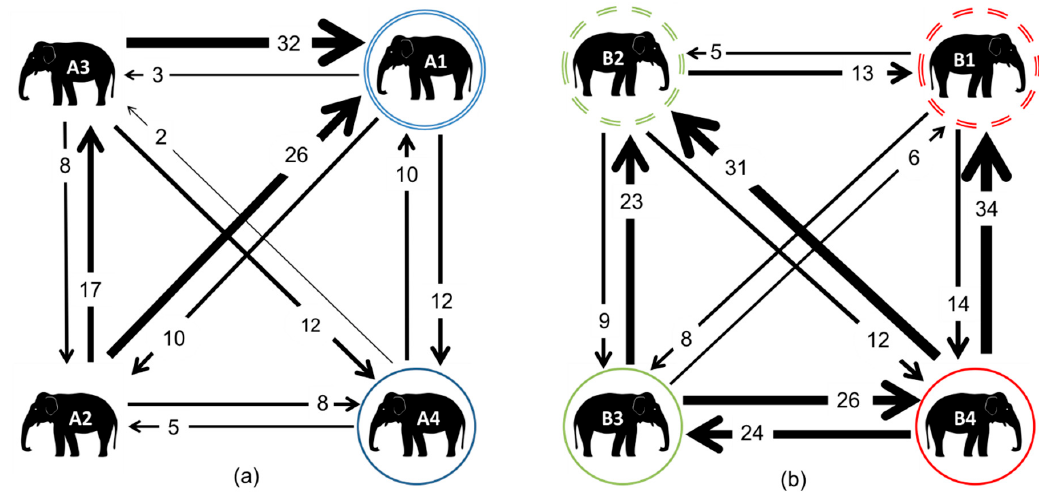
Figure 5. Weighted digraphs based upon affiliative interactions for the elephants at Zoo A ( a ) and Zoo B ( b ). The double circles indicate mothers, whilst matching coloured solid circles indicate their daughters. In Zoo B, all of the individuals were related: dashed circles indicate siblings; their daughters B3 and B4 are therefore cousins, and nieces to the other sibling.